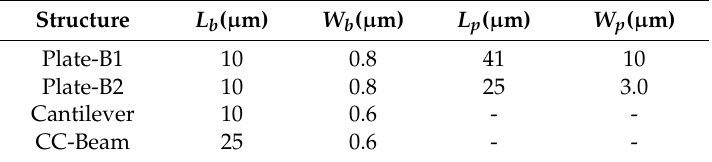
Table 1. Geometrical parameters of the different structures reported in this